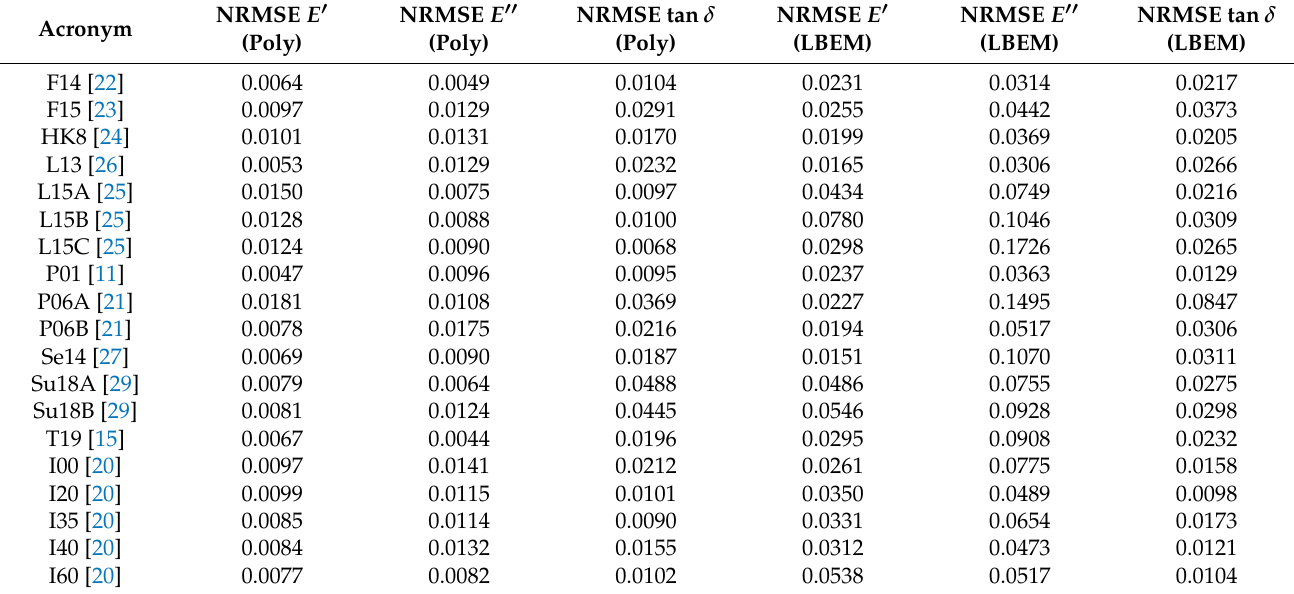
Table 3. Normalised root mean squared error for all the compounds using the polynomial and LBEM models.